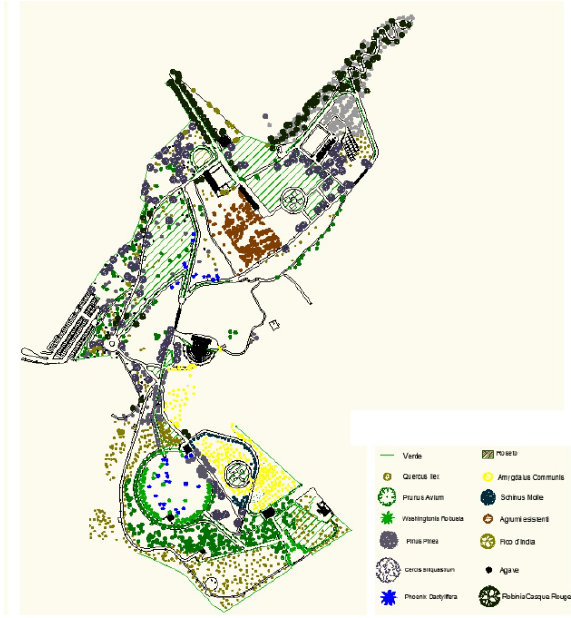
Fig.4: Thematic map of tree